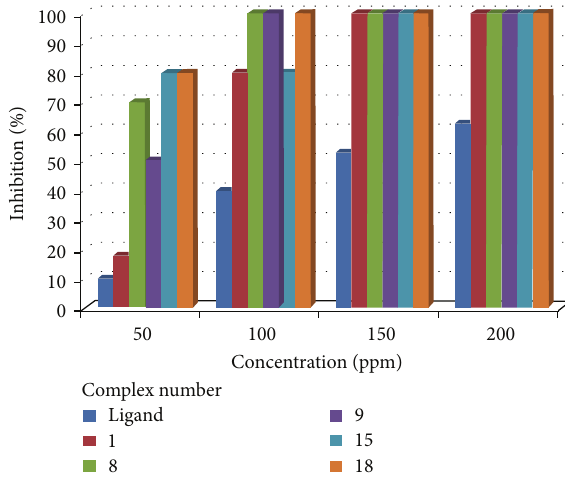
Figure 5: Comparative results of antifungal screening data.